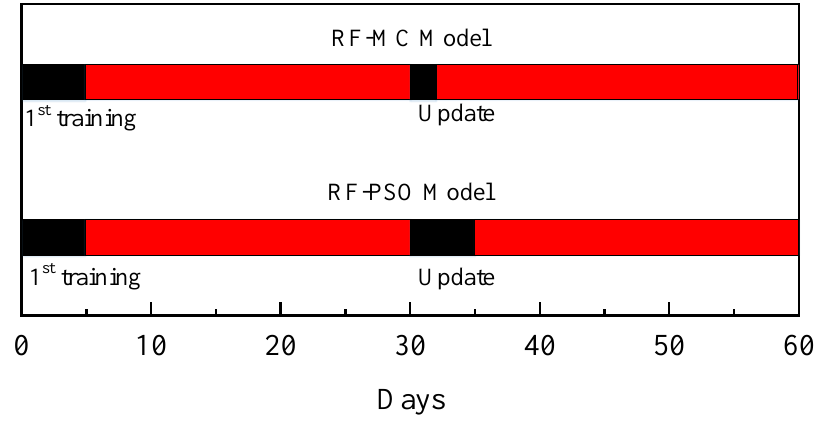
Figure 8. Application comparison of RF-PSO model and RF-MC model.